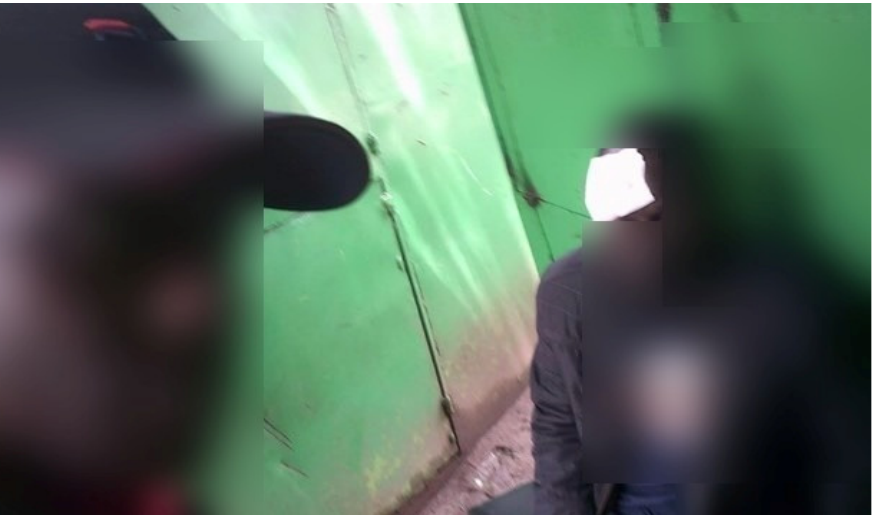
Figure 9. A participant during his regular community visits, attending to a gay refugee attacked by assailants and goons for outright homophobia.